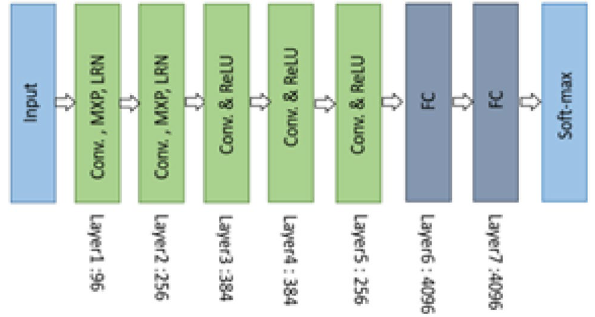
Figure 1. The AlexNet architecture depicting the different layers used for classification 22